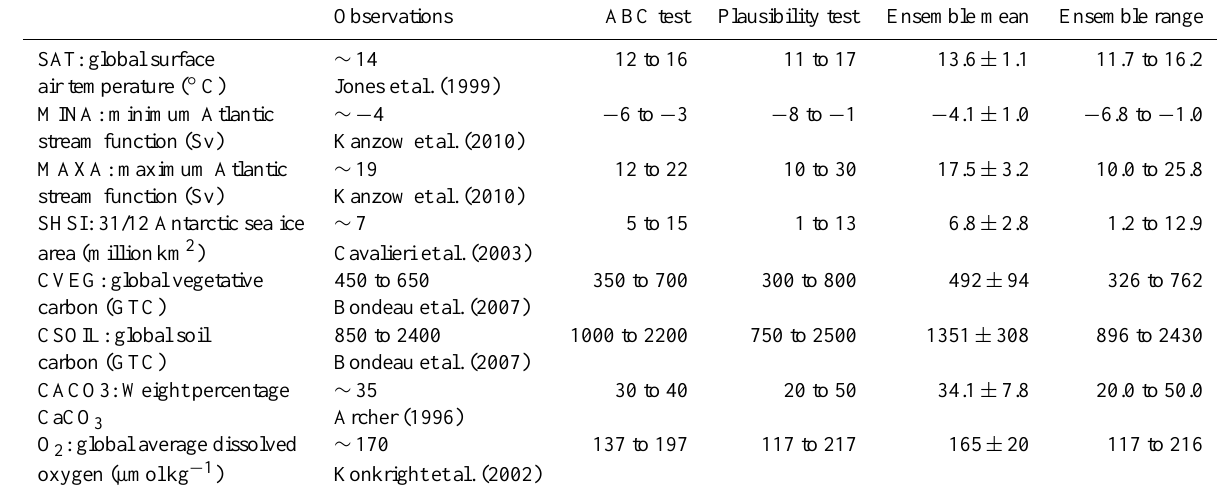
Table 2. The eight plausibility metrics. ABC Test: the “approximate Bayesian calibration” ranges accepted as potentially plausible when a parameter set was applied to the emulators. All eight tests passed for each of the 1000 parameter sets which were applied to the simulator. Plausibility test: the range accepted for a simulation for it to be classified as plausible. All eight tests are passed by the 471 simulations accepted in the EFPC ensemble. Ensemble mean and Ensemble range describe the characteristics of the EFPC